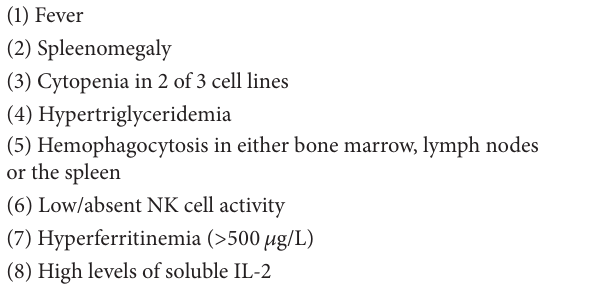
Table 1: Diagnostic criteria of hemophagocytic